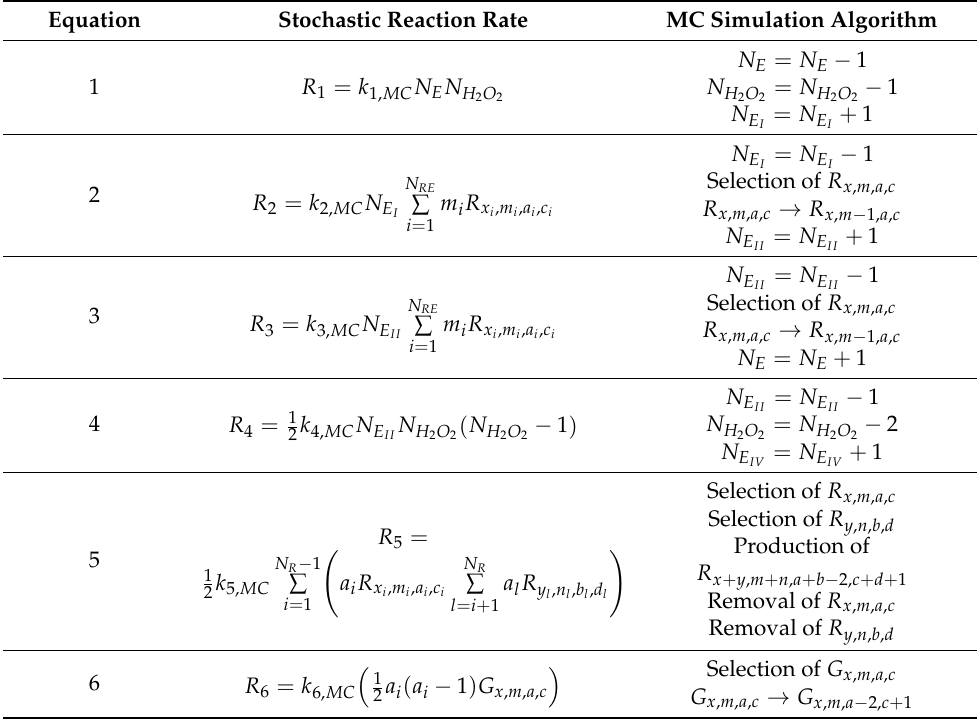
Table 2. Stochastic reaction rates for the 4D MC kinetic model.